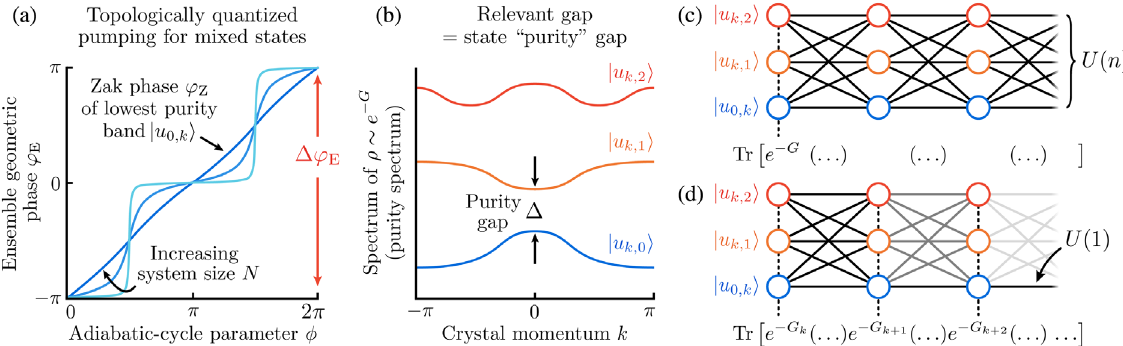
FIG. 1. Key results. (a) Topologically quantized pumping for Gaussian mixed states with translation invariance. The EGP φ of a E mixed state [Eq. (7)] reduces to the Zak phase of a pure state j u as the system size N is increased. The state j u corresponds to the k; 0 i k; 0 i lowest band in the so-called “ purity spectrum ” [see (b)] of the state density matrix ρ . For thermal mixed states ρ ∼ e − β H , it coincides with ϕ Þ the zero-temperature ground state of the Hamiltonian H . When varying a parameter ϕ along a loop from 0 to 2 π , the phase φ E ð changes by a topologically quantized value ( 2 π in the above illustration). This holds irrespective of N and of the state mixedness. The only requirement is a gap in the state purity spectrum. (b) Schematic purity spectrum showing the relevant gap Δ . The density matrix of the state can be expressed as ρ ¼ e − G , where G ¼ − ln ρ is Hermitian [see, e.g., Eq. (8)]. This allows us to define the state “ purity ” eigenvalues and eigenvectors in analogy with spectral features of a Hamiltonian (where “ purity ” refers to the fact that eigenvalues indicate the degree of purity of ρ in each eigenspace [19]). (c),(d) Crucial difference between conventional few-body observables and the many-body EGP considered in this work. While the former take the symbolic form approximately Tr ½ ρ ð … Þ(cid:2) ¼ Tr ½ e − G ð … Þ(cid:2) , the phase φ has a more rigid structure approximately Tr ½ e − G k ð … Þ e − G k þ 1 ð … Þ … (cid:2) , where G denotes the matrix G in the momentum sector k . k E This structure corresponds to a path-ordered product over points k ¼ 1 ; … ; N across the Brillouin zone (Sec. III A). In the state eigenbasis fj u (where s ¼ 0 ; 1 ; … ; n − 1 indexes purity bands), matrices e − G and e − G k are diagonal and can be seen as “ weight k;s ig represented by circles are connected by operators ð … Þ ], a single factors. ” In the conventional case depicted in (c) [where states j u k;s i “ selection ” by weight factors occurs (indicated by a dashed line). For the EGP, in contrast, a thermodynamically large number of times N of selections come into play. As a result, connections to states j u with s > 0 are efficiently damped, and the EGP exhibits the U ð 1 Þ k;s i alone (up to corrections that vanish in the limit N → ∞ geometric properties of j u k; 0 i